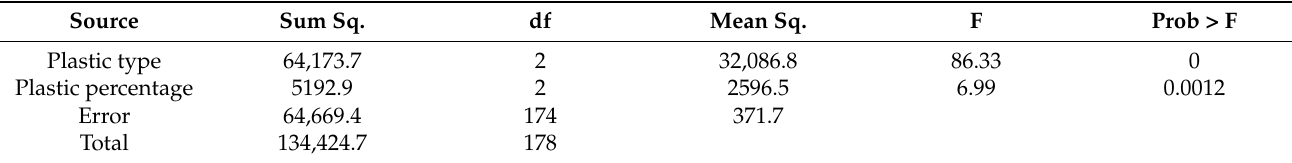
Figure 8. The effect of the type of plastic and the wood–plastic ratio on the feed force (F [N]). Table 6. The results of using ANOVA to verify the statistical significance of the impact of plastic type and plastic percentage on the on the drilling torque (T (Nm)).